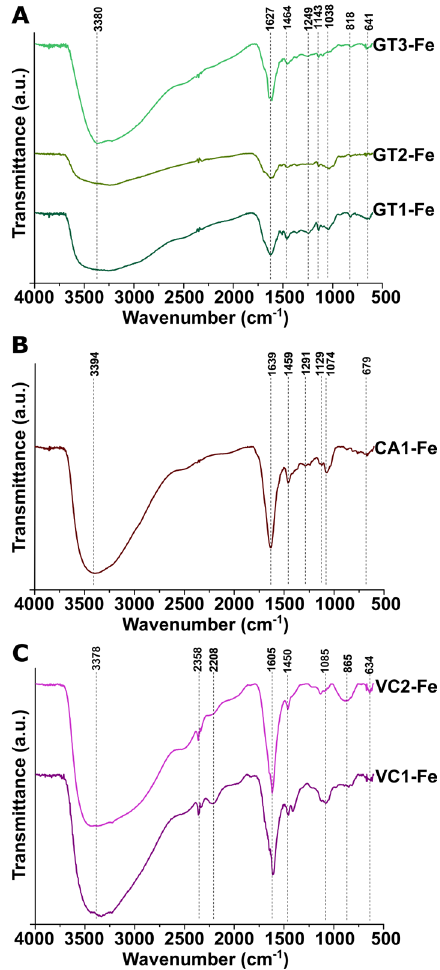
Fig. 3 FT-IR spectra of iron nanoparticles produced by using various green waste extracts. Spectra of FeNPs generated with green tea solu- tions of three subsequent extraction rounds (GT1-Fe, GT2-Fe, and GT3-Fe) are shown in panel A , the spectrum of FeNPs obtained with first- round coffee extract (CA1-Fe) is presented in panel B , and FT-IR spectra of FeNPs of first and second extractions of Virginia creeper (VC1-Fe, VC2-Fe) are shown in part